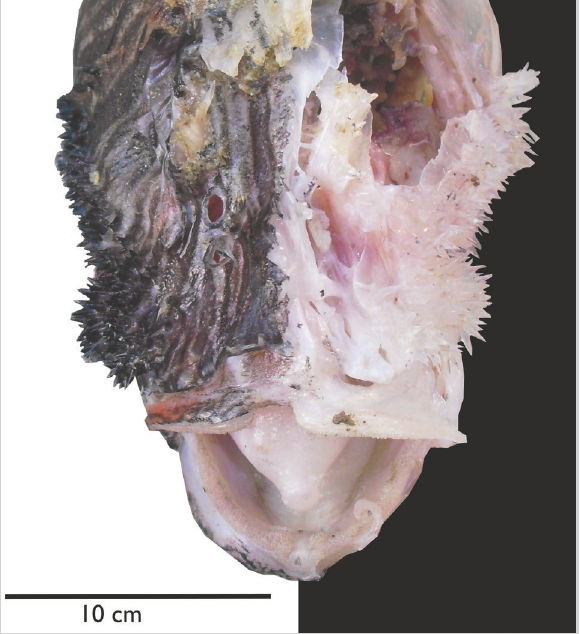
Fig. 2. Dorsal view of the head of the Pterois volitans specimen, showing the level of development of the bony ridge of some of the head bones on both sides